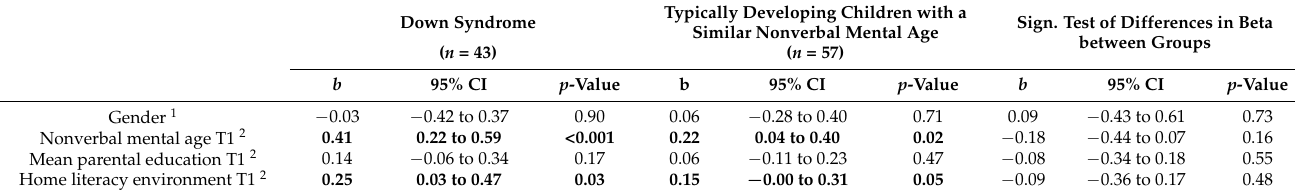
Table 4. Multivariable analysis of the predictors of expressive language over time for children with Down syndrome and typically developing children with a similar nonverbal mental age, with gender, parental education and nonverbal mental age controlled.